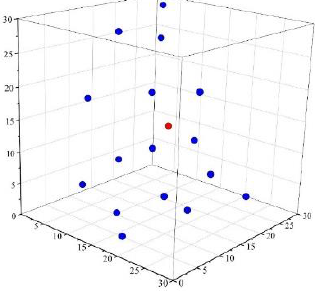
Figure 4. Collision avoidance of wolves.